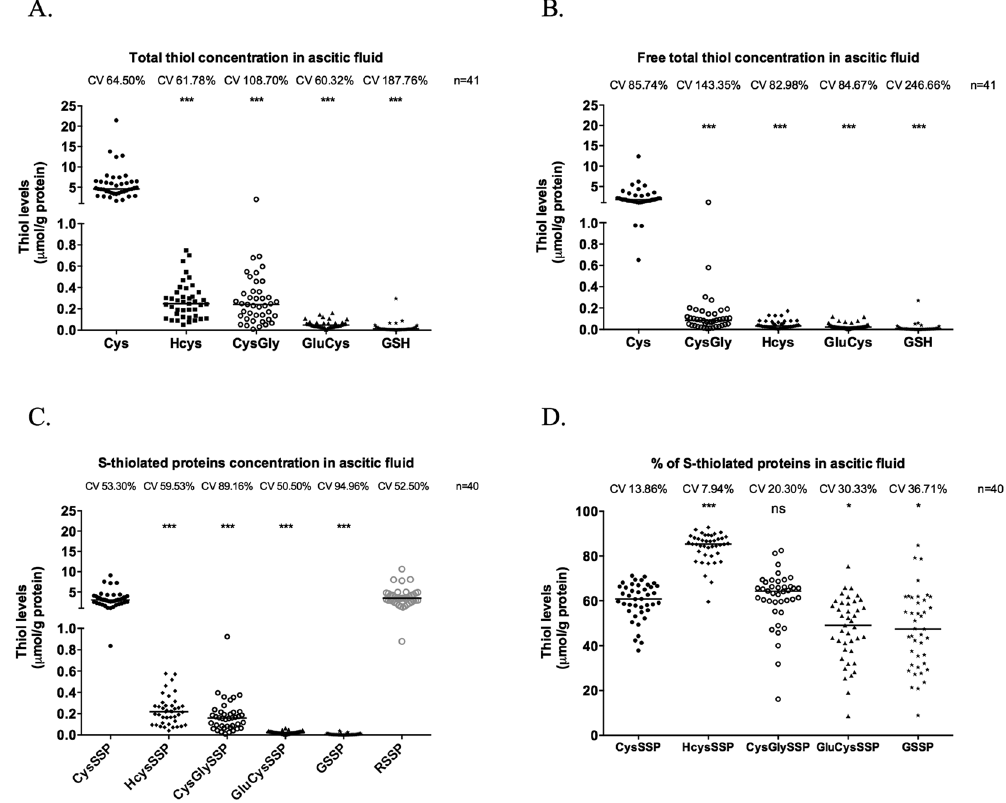
Figure 8. Cysteine is the prevalent thiol in ascitic fluid from patients with ovarian cancer. Thiols quantification in ascitic fluid from patients with ovarian cancer. ( A ) Total thiols concentration. ( B ) Free total thiols concentration. ( C ) Thiols concentration bound to proteins. ( D ) Percentage of thiols concentration bound to proteins. Cys – cysteine, HCys- Homocysteine, CysGly – Cysteinylglycine, GluCys – Glutamylcystein, GSH – Glutathione, CysSSP – S -cysteinylated proteins, HcySSP – S-homocysteinylated proteins, CysGlySSP – S-cysteinylglycinylated proteins, GluCysSSPS – Glutamylcysteinylated proteins, GSSP – S-glutathionylated proteins, RSSP – total S-thiolated proteins. Thiol concentration was normalized by protein concentration. Results are shown as median. The * represent the statistical significance in relation to Cysteine concentration. * p < 0.05, ** p < 0.01, *** p < 0.001 (independent samples Kruskal Wallis One-way ANOVA with multiple